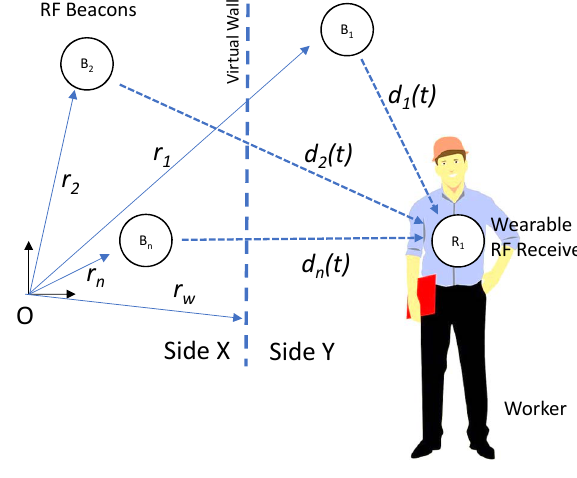
Figure 4. Schematic of the virtual fence